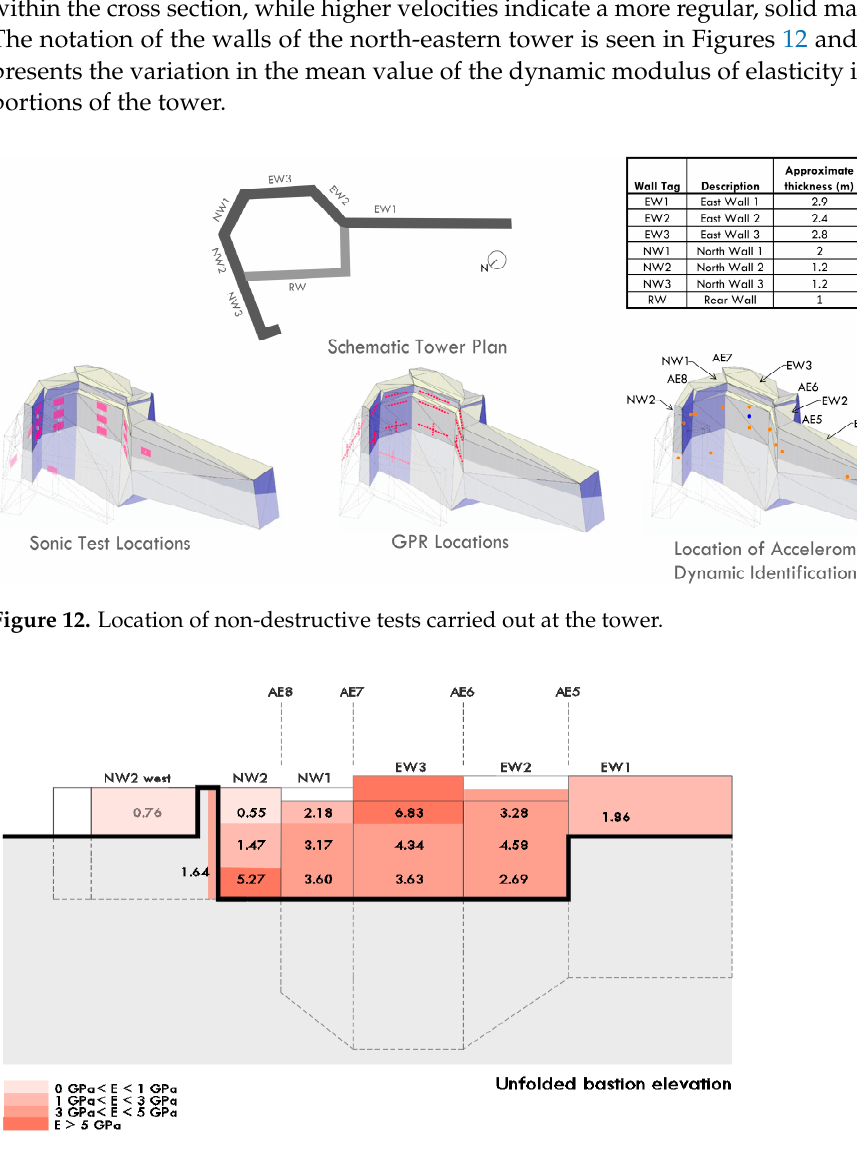
Figure 13. Unfolded tower elevation showing mean E d values calculated.